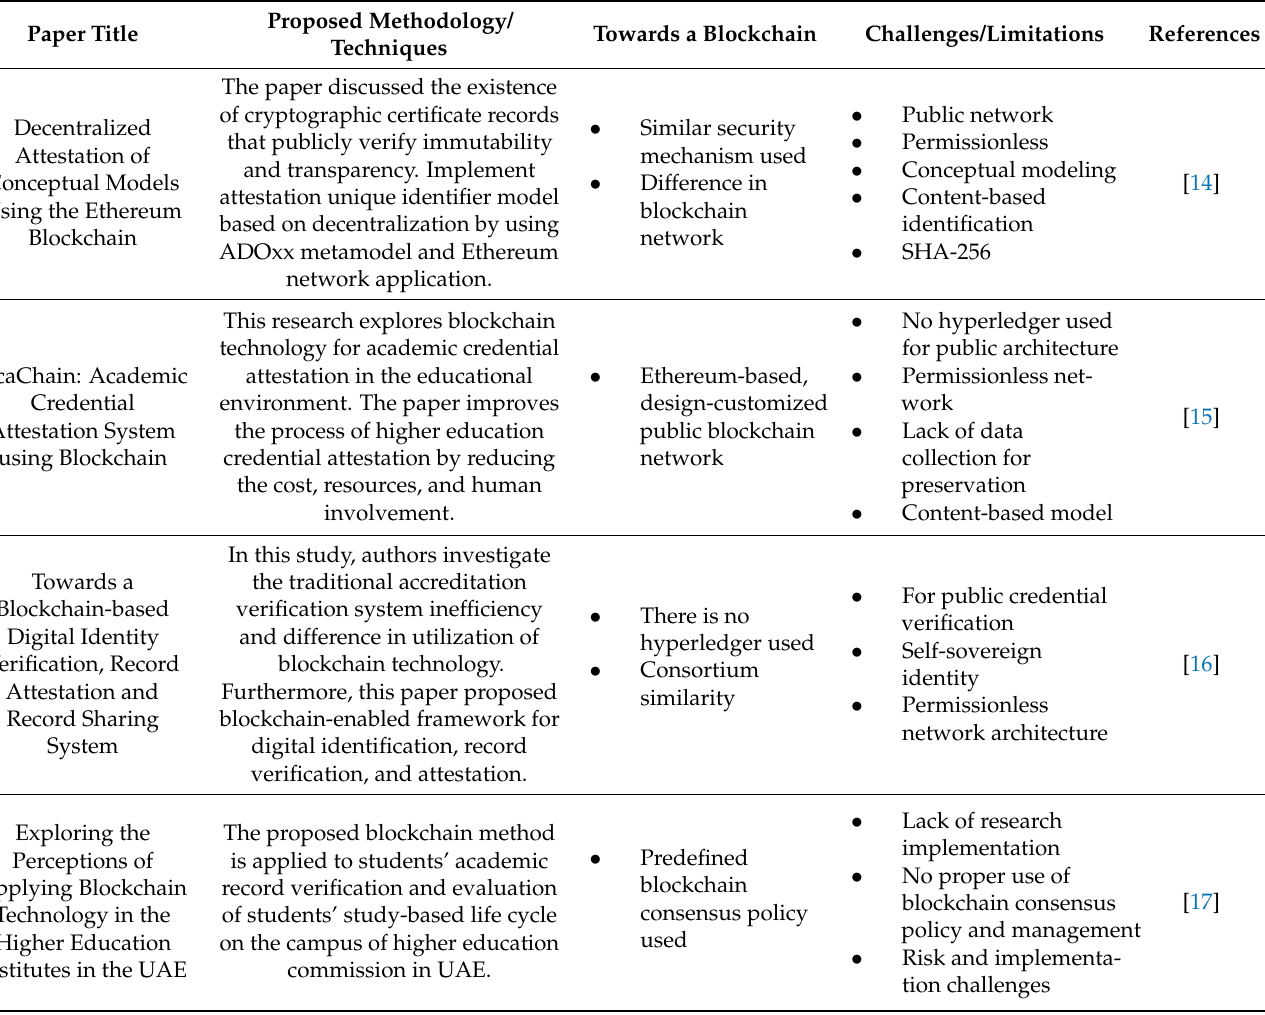
Table 1. Related literature of blockchain hyperledger enables higher education degree attestation